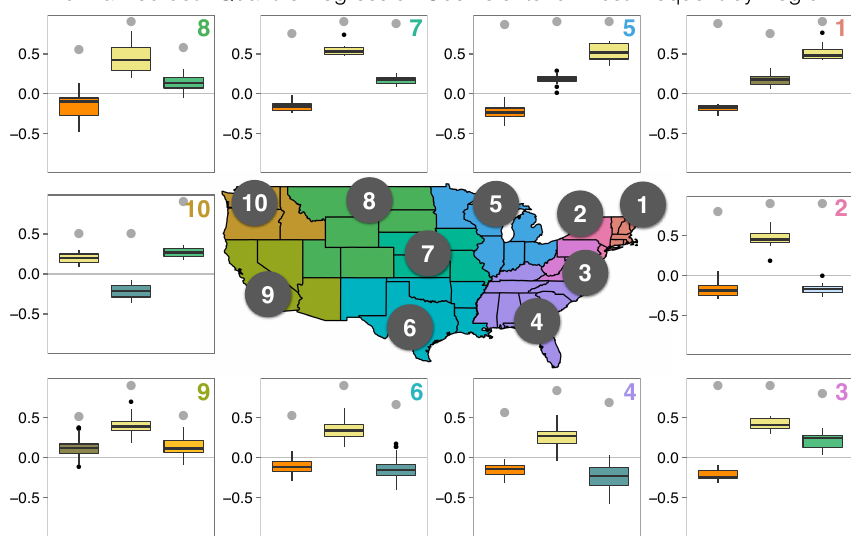
Figure 5. Same as Fig. 4, but for winter O 3